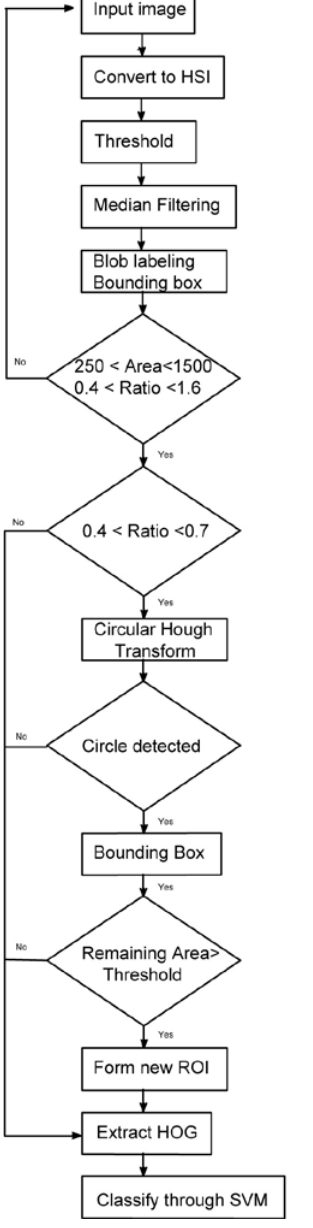
Figure 2. Workflow of the method